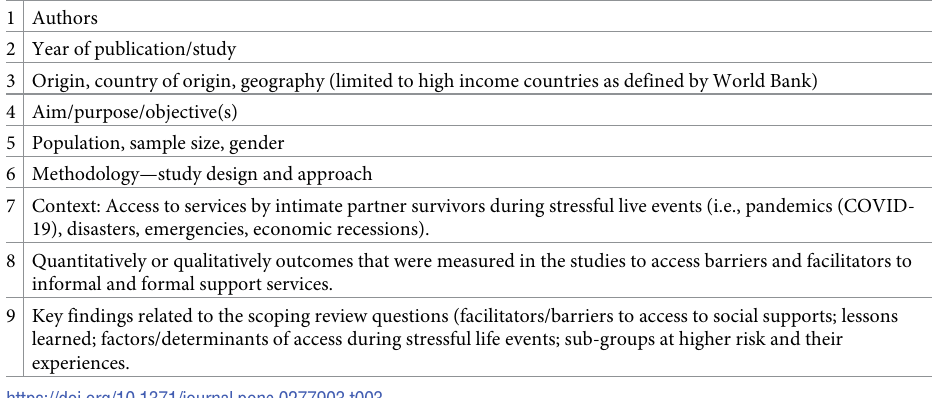
Table 3. Extraction tool (Peters et al.,